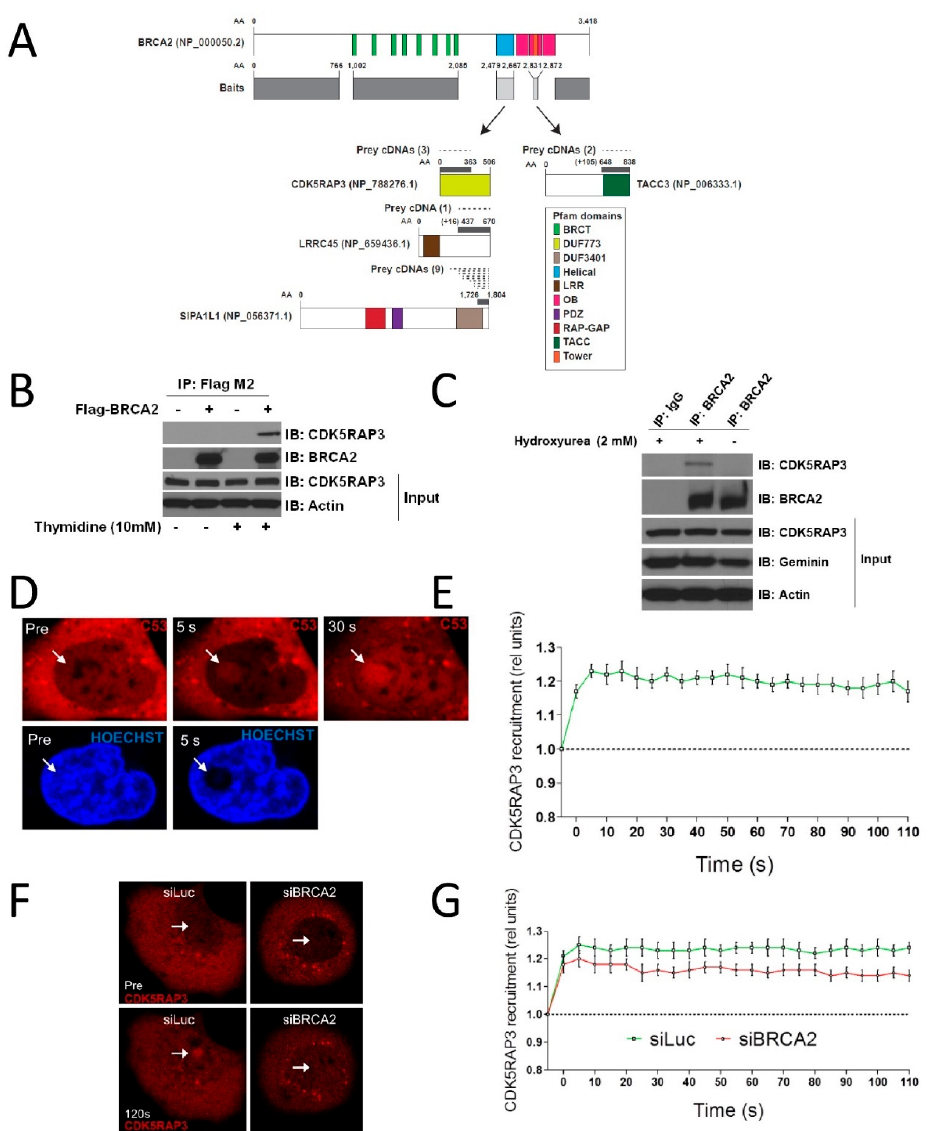
Figure 1. CDK5RAP3 interacts with BRCA2 and relocates to DNA damage. ( A ) BRCA2 fragments used as baits for Y2H assay and potential interactors found (see materials and methods). ( B ) BRCA2 immunoprecipitation in HEK 293T cells expressing empty vector or Flag-BRCA2, double thymidine treated to enrich S-phase cells, or left untreated. ( C ) Endogenous BRCA2 IP in HEK 293T cells, S-phase synchronized with hydroxyurea or left untreated. ( D ) Laser micro-irradiation of U2OS cells stably expressing Cherry-CDK5RAP3. Representative image shows very fast CDK5RAP3 localization to DNA damage sites. ( E ) Time course of CDK5RAP3 DNA damage localization. ( F ) CDK5RAP3 localization after micro-irradiation in U2OS cells upon BRCA2 depletion. Representative image shows reduced CDK5RAP3 relocation in BRCA2 depleted cells. ( G ) Time course of CDK5RAP3 relocation to DNA damage upon BRCA2 depletion.